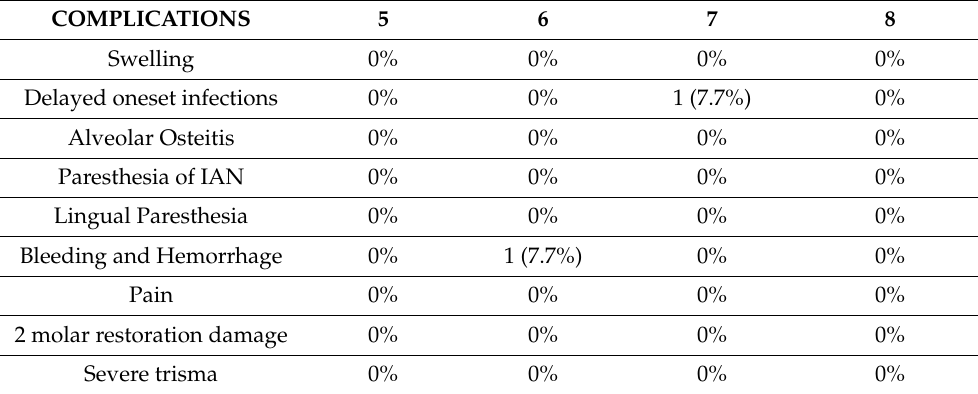
Table 4. Complications according to Nolla’s classification of the impacted mandibular third molars.